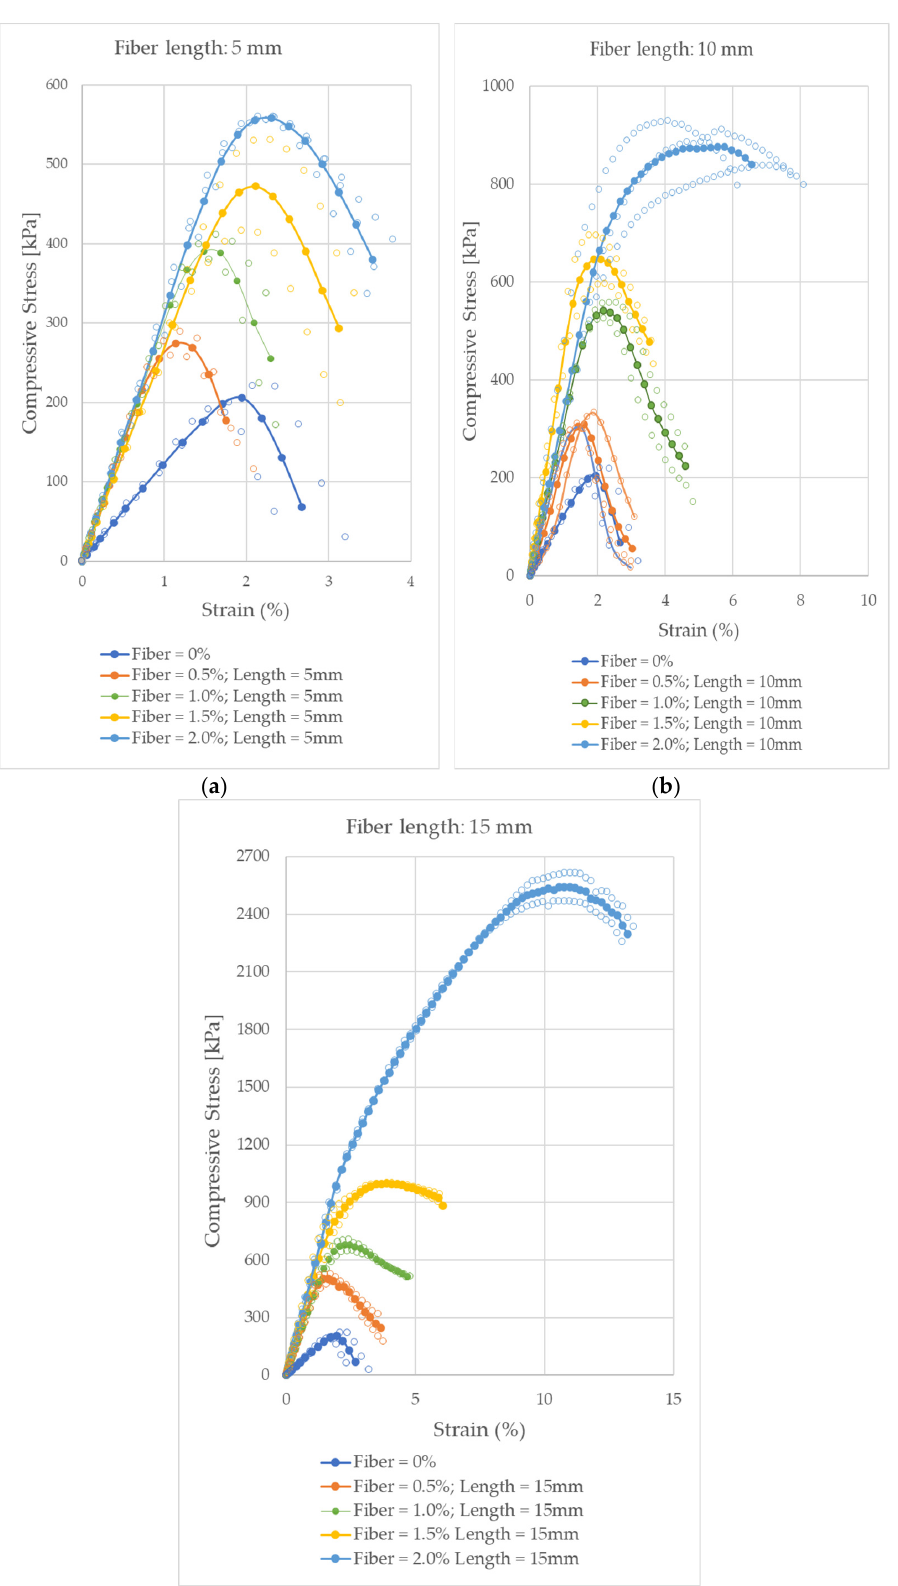
Figure 12. Stress–strain curve with variations of fiber content and fiber length ( a ) 5 mm; ( b ) 10